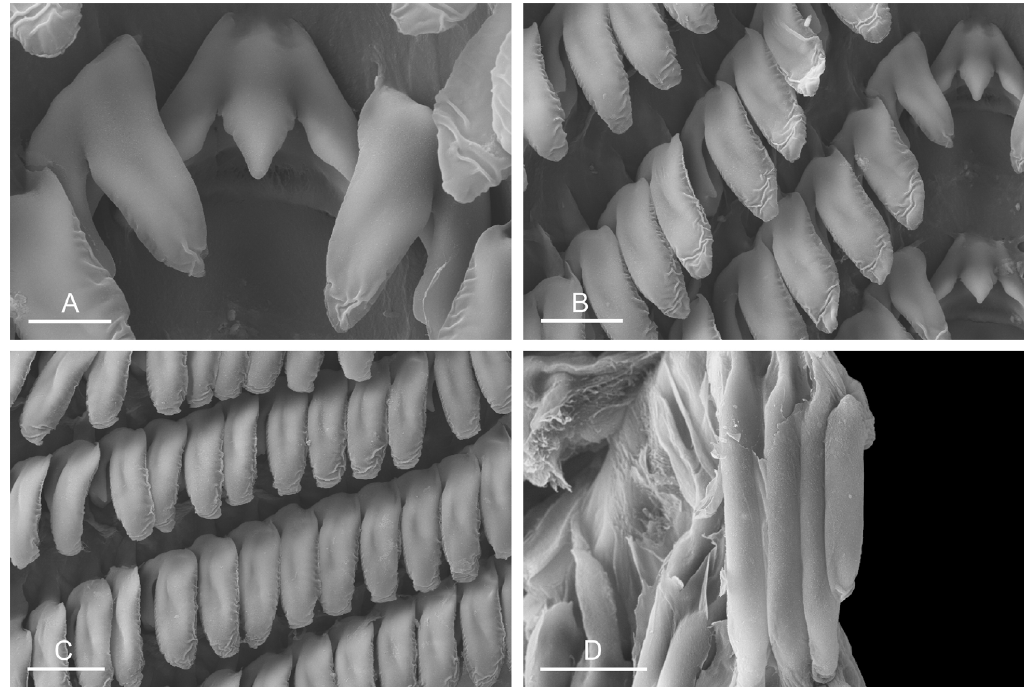
Fig. 14. Paromoionchis tumidus (Semper, 1880) comb. nov. unit #2 , radula, Australia, Northern Territory [1638] (NTM P.57623). A . Rachidian and innermost lateral teeth. B . Lateral teeth with rachidian teeth. C . Lateral teeth. D . Outermost lateral teeth. Scales: A = 30 μm; B–C = 50 μm; D = 20 μm.